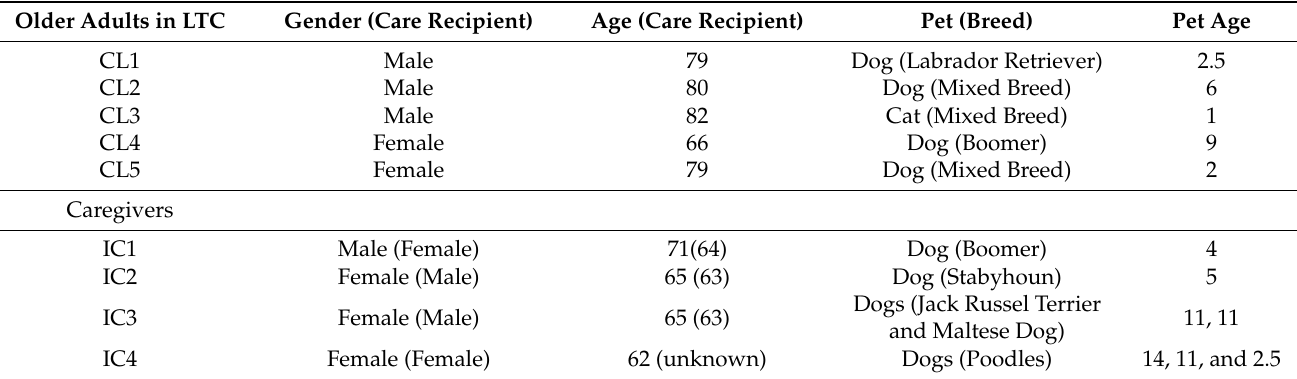
Table 1. Participant and Pet